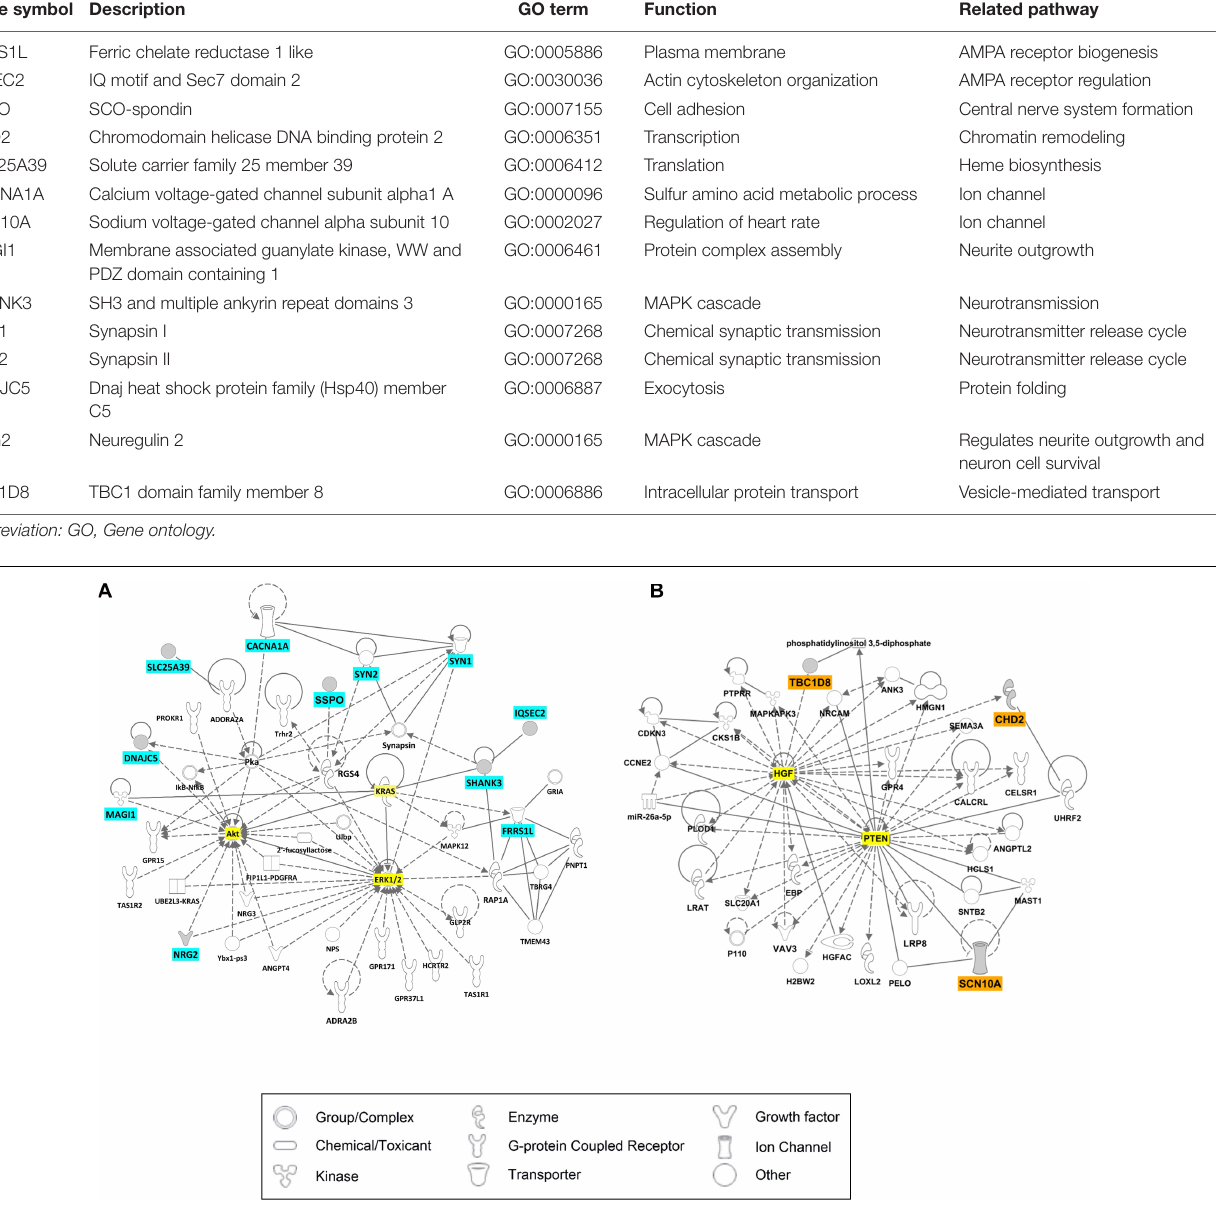
FIGURE 4 | Ingenuity Pathway Analysis (IPA) results for candidate genes of LGS or LGS-like epilepsy. The genes with cyan or orange colors indicate candidate genes selected in this study. The genes with yellow color represent those most relevant to the candidate genes. (A) Cell signaling network. (B) Neurological disease